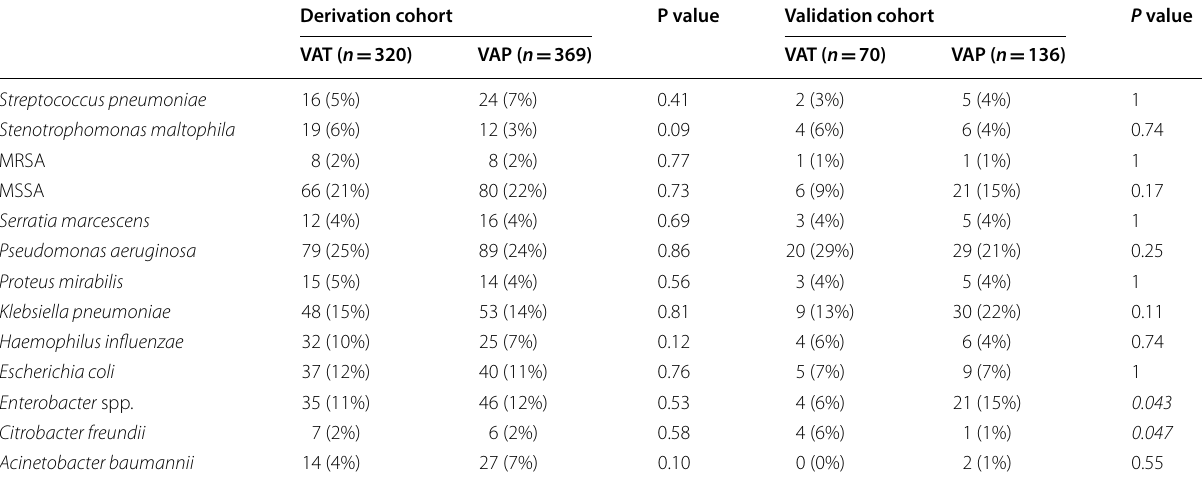
Data are presented as number (%) or mean (SD) COPD Chronic obstructive pulmonary disease, MSSA Methicillin-sensitive Staphylococcus Aureus , MRSA Methicillin-resistant Staphylococcus Aureus, SAPS Simplified acute physiology score, SOFA Sequential organ failure assessment, VAP Ventilator-associated pneumonia, VAT Ventilator-associated tracheobronchitis p values < 0.05 are indicated in italic